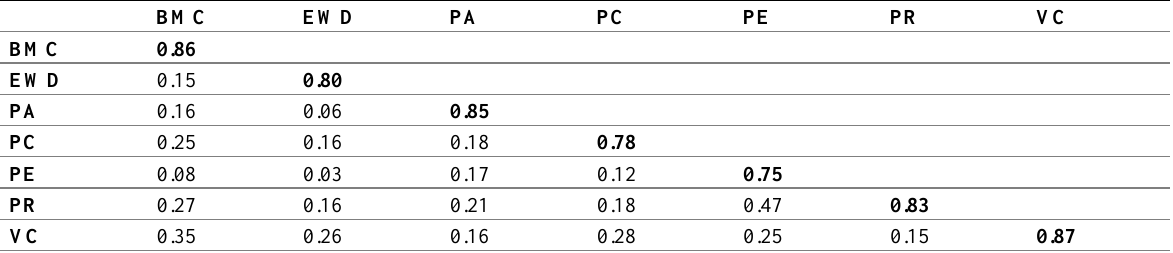
Table 3 : Discriminant Validity Analysis (Fornell-Larcker Criterion)